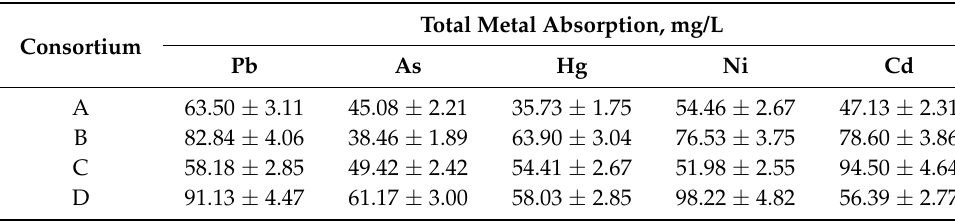
Table 6. Total absorption of individual metals by various consortiums.